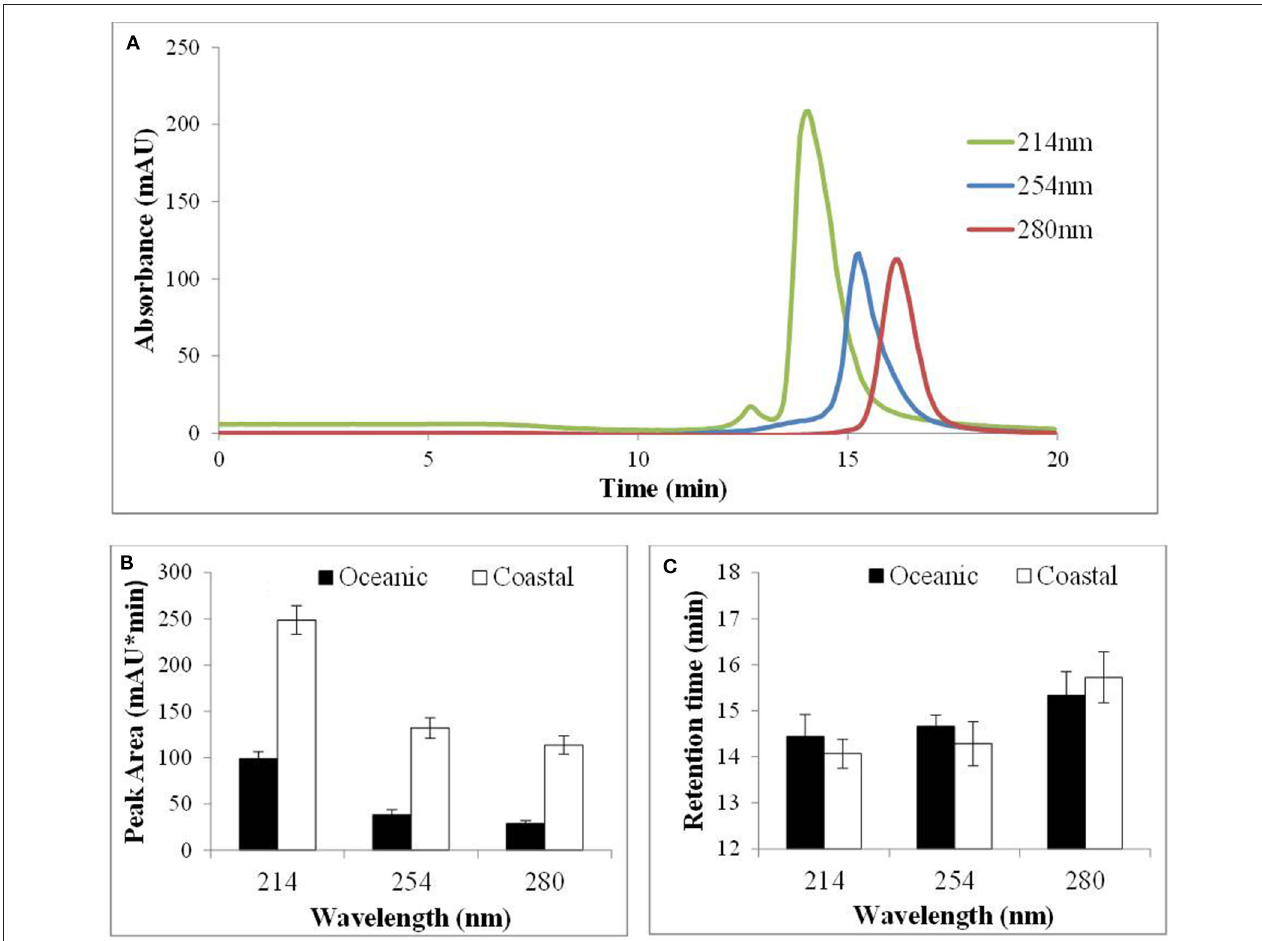
FIGURE 4 | Immobilized copper(II)-ion affinity chromatography of coastal (CSW) and oceanic surface seawater (OSW) samples using the AKTA system (see text) to monitor the elution of replicate samples at 214, 254, and 280 nm. (A) Extracted compounds that absorb most strongly at each wavelength were found to elute at different times. (B) Peak areas were reproducible ( n = 10; error bars represent 1 SD) and were consistently greater for coastal than for oceanic surface seawater. (C) Retention times were significantly greater for compounds that absorbed most strongly at 280 nm but were no different for CSW than for OSW